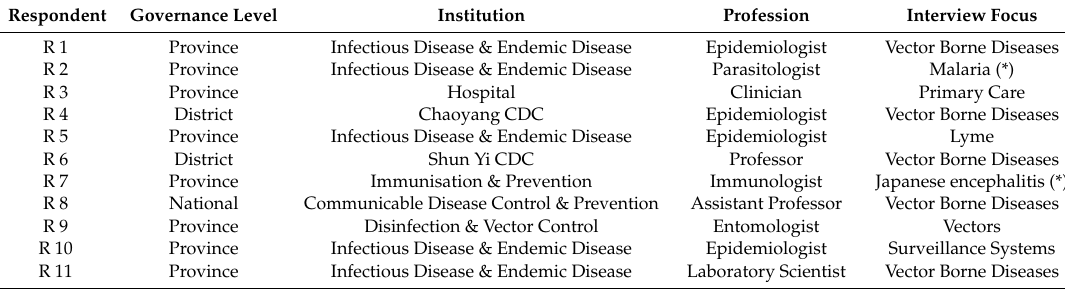
Table 1. Characteristics of experts who participated in this study. (*) Indicates use of a translator during one-to-one